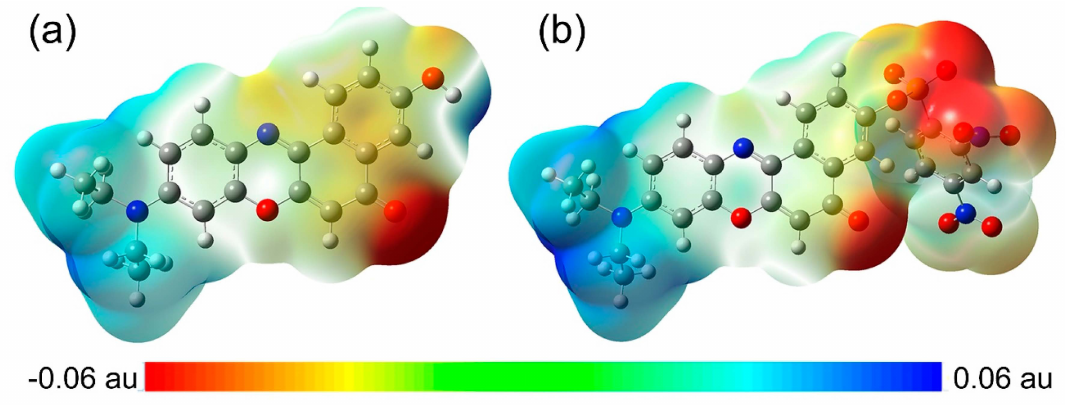
Figure 6. Molecular electrostatic potential (MEP) maps for ( a ) NR and ( b ) NRSH